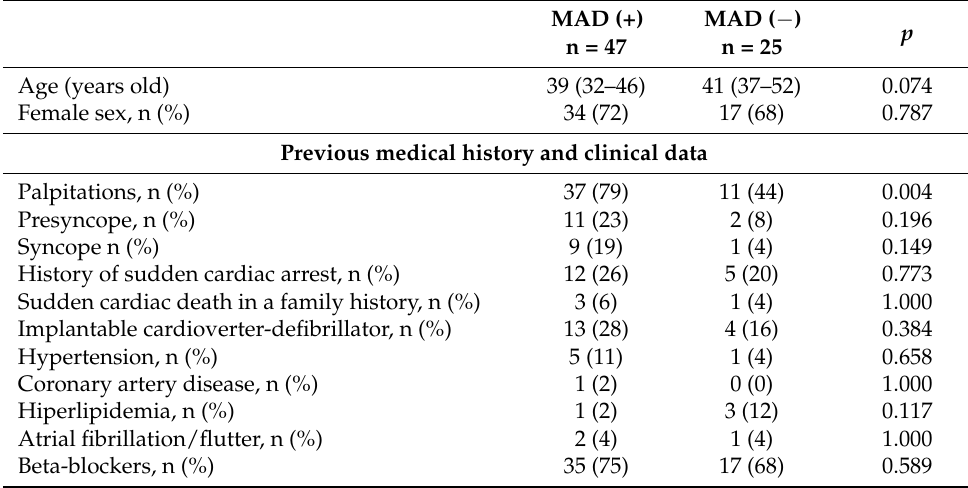
Table 2. Clinical characteristics of MVP patients according to MAD